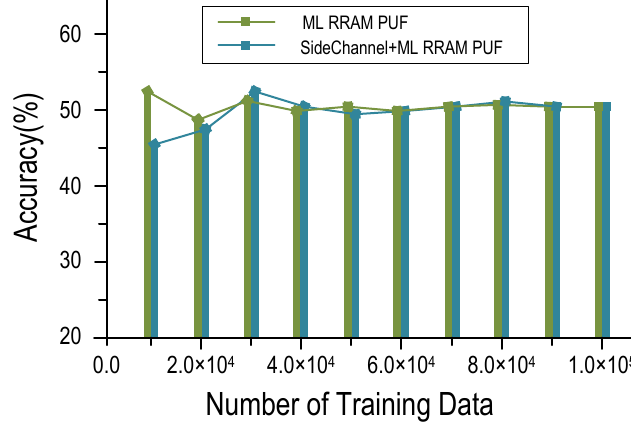
Figure 5. The prediction accuracy for RRAM